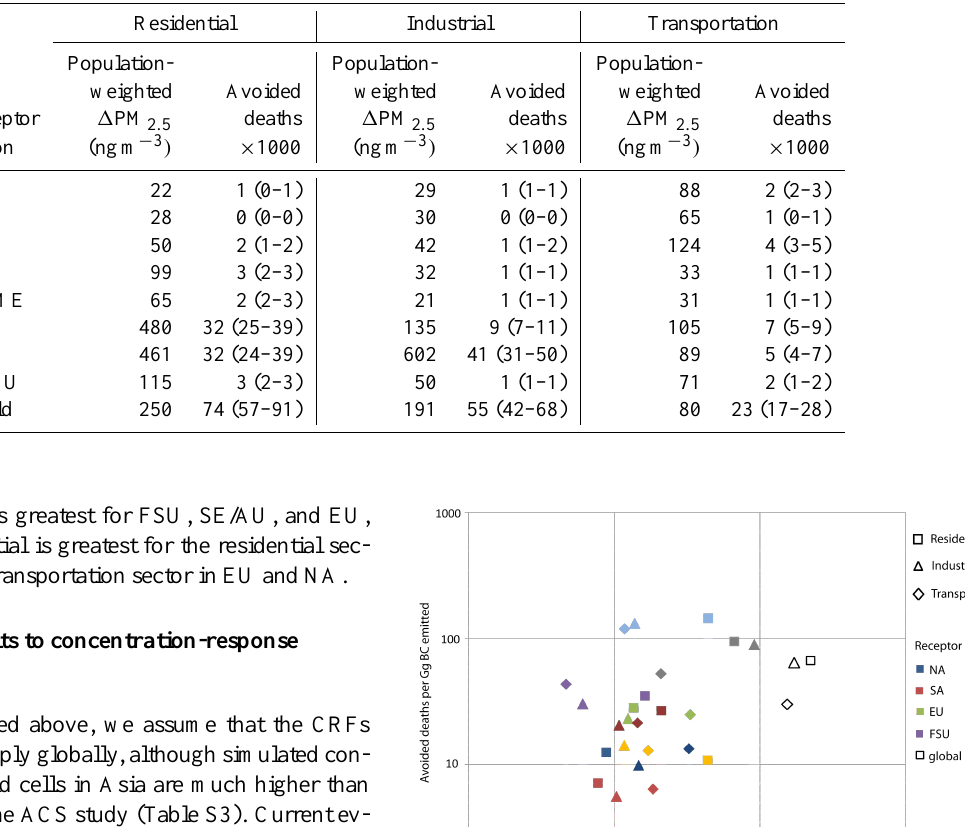
Table 3. Population-weighted reduction in annual average PM 2 . 5 (ngm − 3 ) and annual avoided premature cardiopulmonary and lung cancer deaths (in thousands) for halving global BC emissions from each sector, relative to the base case. Confidence intervals (95%, in parentheses) reflect uncertainty in the CRF only.